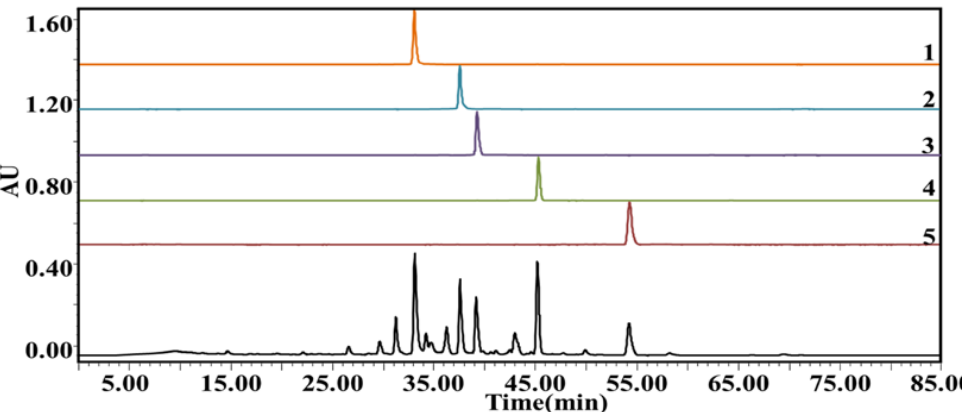
Figure 6. Chromatograms of AChEIs isolated from P. cocos crude extracts using HSCCC and semi − preparative HPLC. Compounds identified: (1) Tumulosic acid (98.11%); (2) Polyporenic acid C (96.29%); (3) 3 − Epidehydrotumulosic acid (95.40%); (4) Pachymic acid (97.31%); (5) Dehydrotrametenolic acid (97.82%).